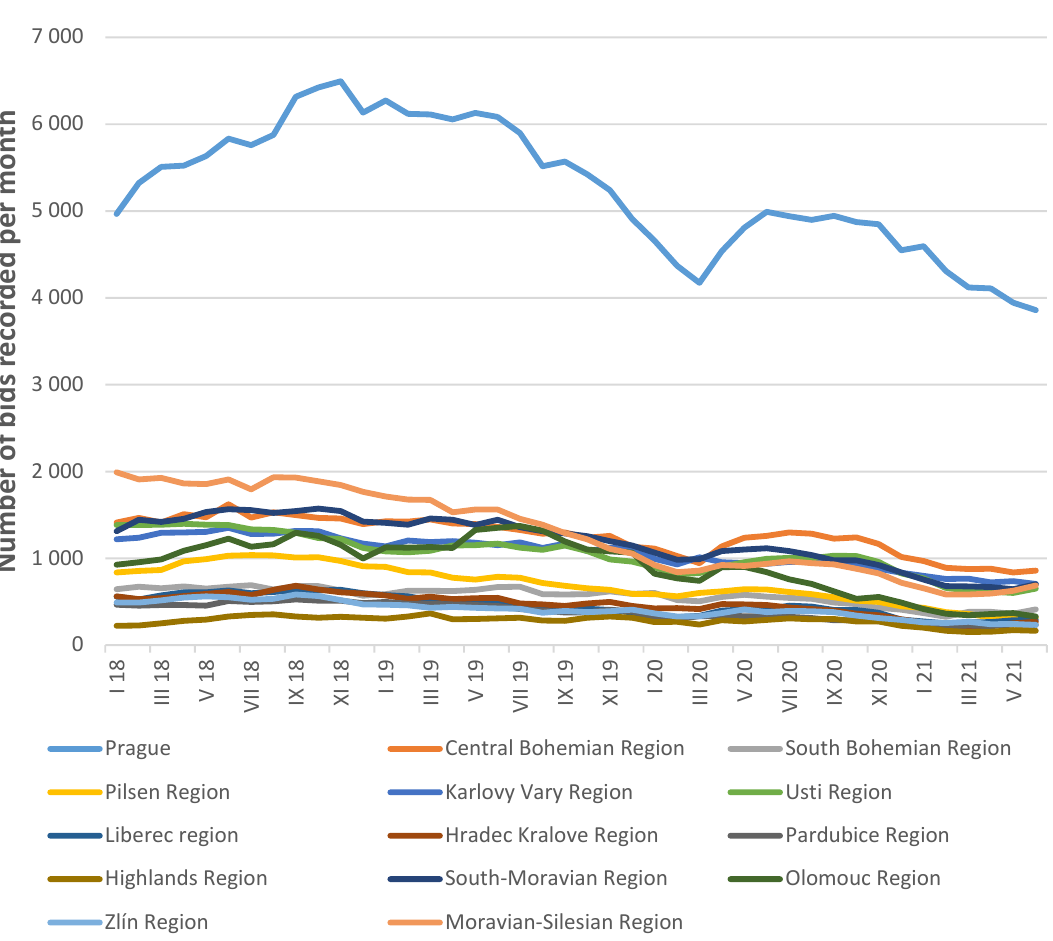
Figure 1: The number of published offers in real estate advertising per month in the category of apartments for sale, January 2018 to June